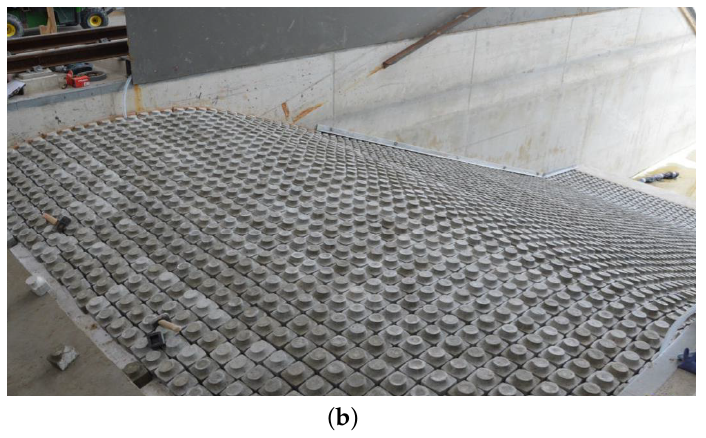
Figure 2. ( a ) Scaled Grassblock (12 × 12 × 10cm) as used in the physical tests [13]. ( b ) Grassblocks installed on crest and landward slope in the Deltares Delta flume